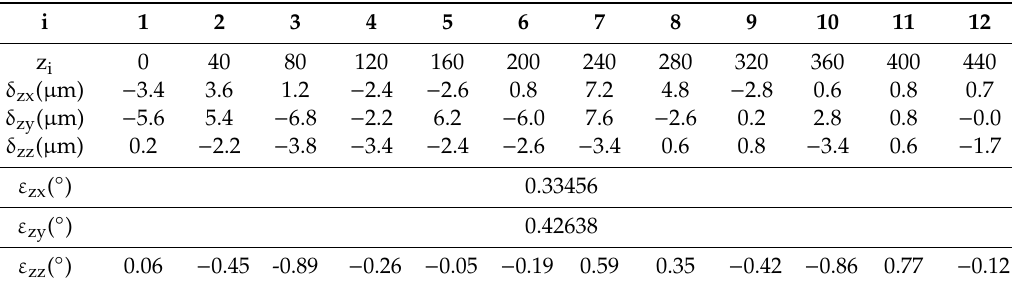
Table A3. Complete geometric errors of the Z-axis.